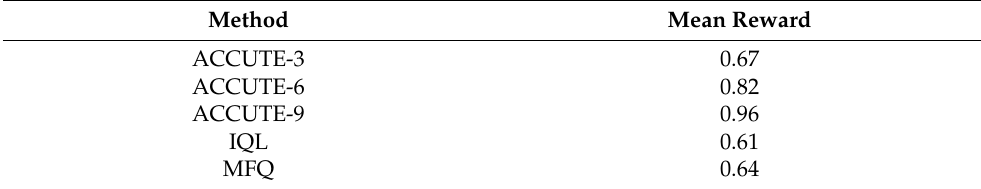
Table 5. Mean reward per episode on lbforaging: 5s-19 ×